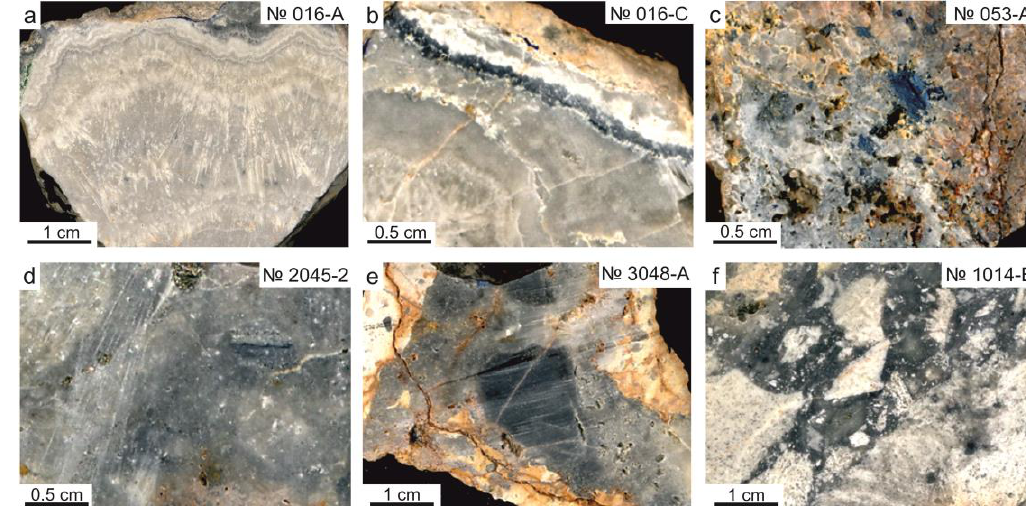
Figure 2. Typical textures of Corrida ores: ( a )—combination of crustify‐platy and colloform‐banded; ( b )—banded; ( c )—massive; ( d )—fragmentally brecciform; ( e )—porous; ( f )—breccia (fragments of monoquartzites in cryptocrystalline quartz).